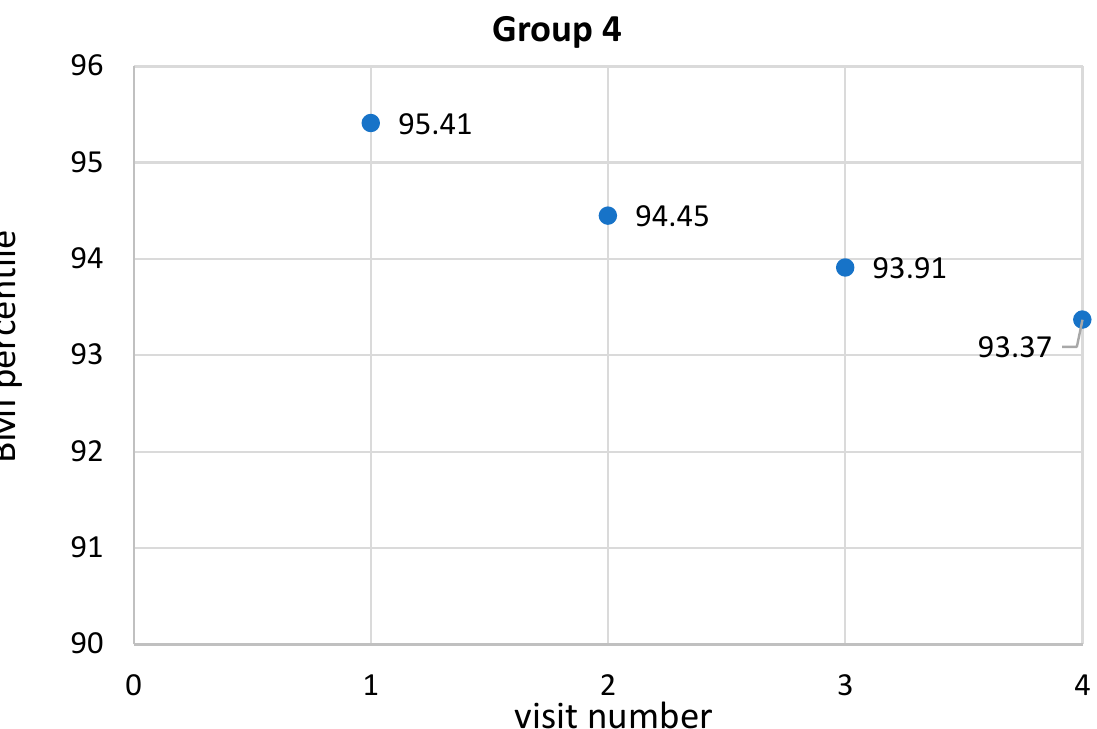
Figure 3. WHR index in children with overweight and obesity at consecutive visits.